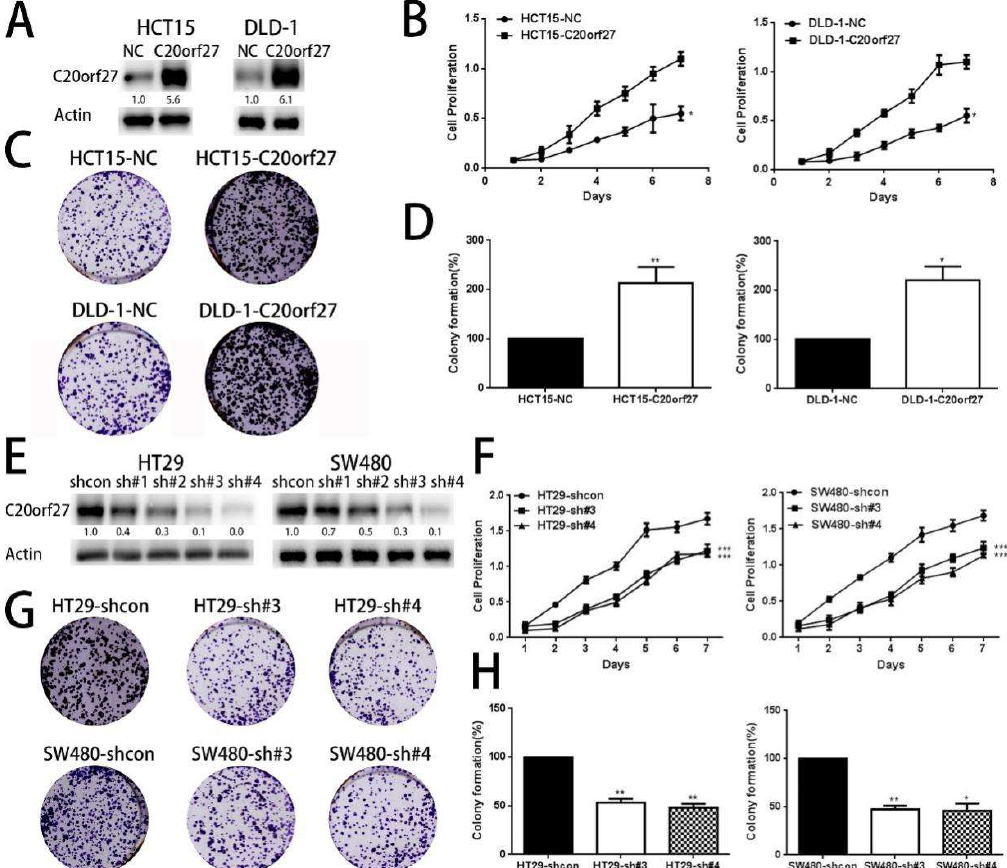
Figure 1. C20orf27 promotes the growth and proliferation of CRC cells in vitro. ( A ) Overexpression of C20orf27 in HCT15 and DLD-1 cell lines was confirmed using Western blot analysis; ( B ) Changes in absorbance after overexpression of C20orf27 in HCT15 and DLD-1 cells as detected by WST-1 (Highly water-soluble tetrazolium salt-1) assay; ( C ) and ( D ) Clone formation assays in overexpressing C20orf27 and control cells of HCT15 and DLD-1; ( E ) C20orf27 silencing in SW480 and HT29 cell lines was confirmed by Western blot analysis; ( F ) Changes in absorbance after C20orf27 silencing in SW480 and HT29 cells as detected by WST-1 assay; ( G ) and ( H ) Clone formation assays in C20orf27 silencing and their control cells of SW480 and HT29. * p < 0.05, ** p < 0.01, *** p < 0.001.